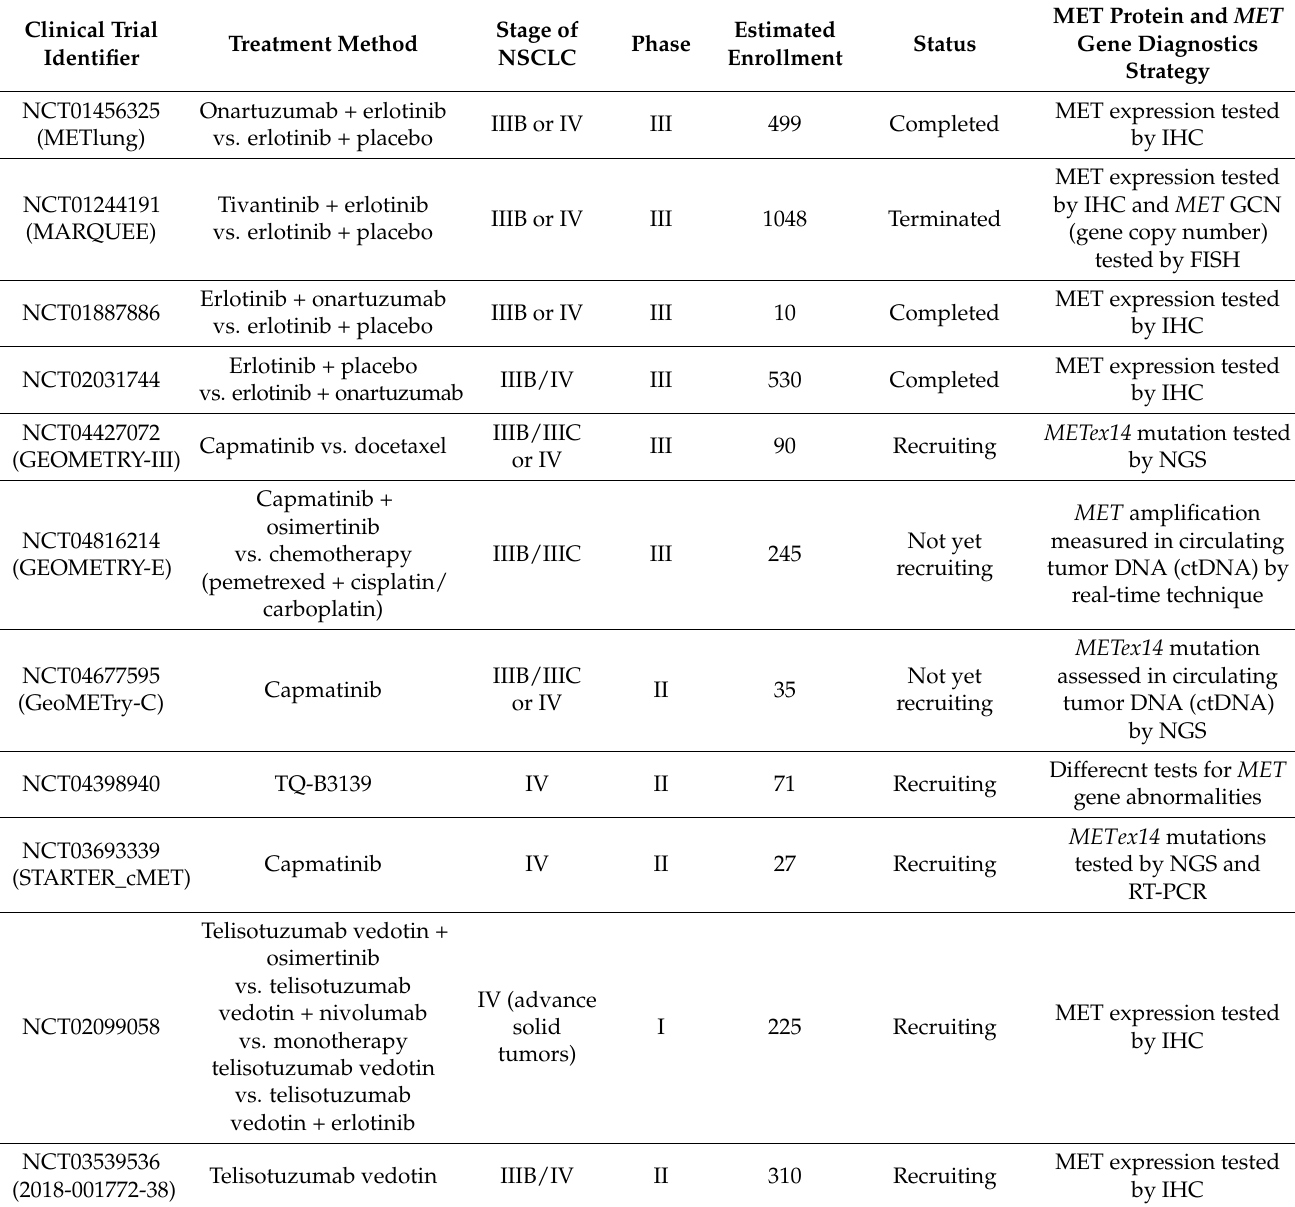
Table 2. Clinical trials investigating MET TKI efficacy in NSCLC